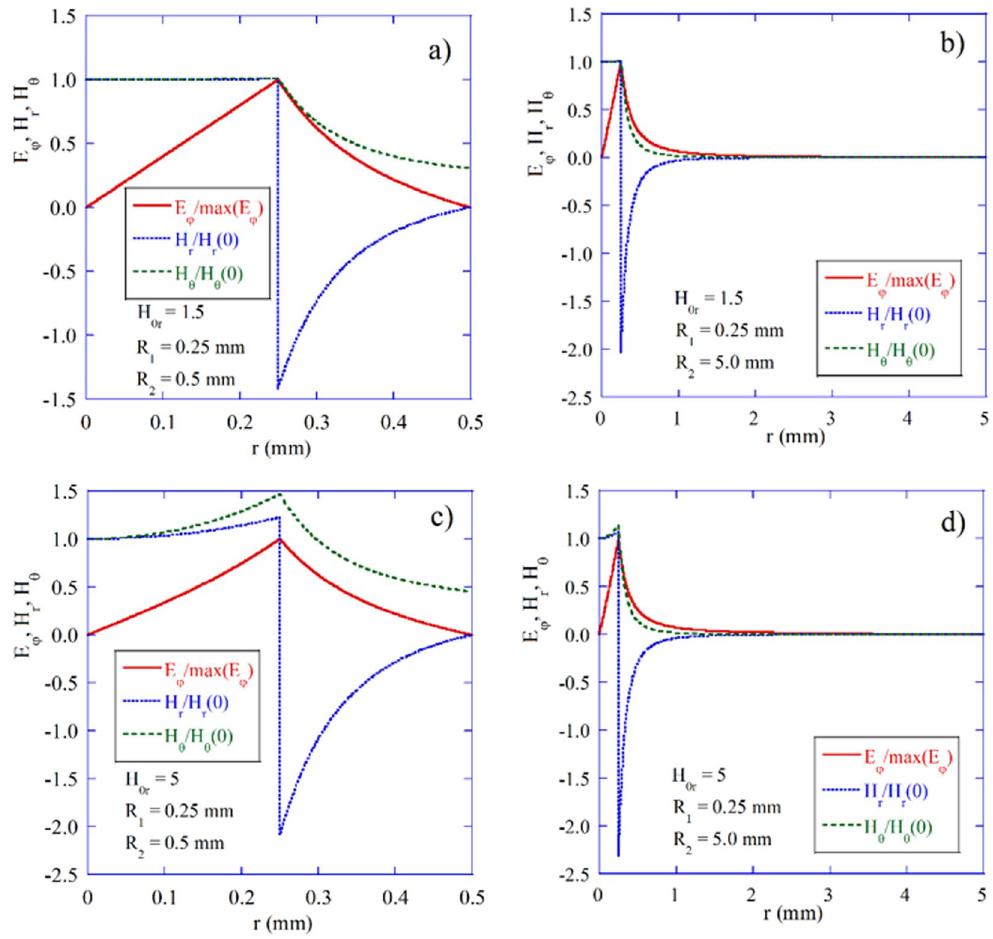
Figure 3. EM fields. Distribution of EM fields at the MPR for the gyromagnetic sphere situated at the center of spherical cavities of two different sizes calculated for two magnetic field bias